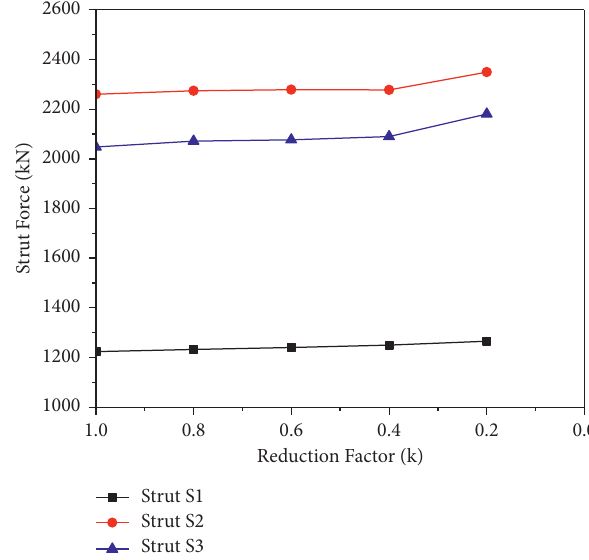
Figure 7: The relations between pre-augering loosening effect and the maximum strut